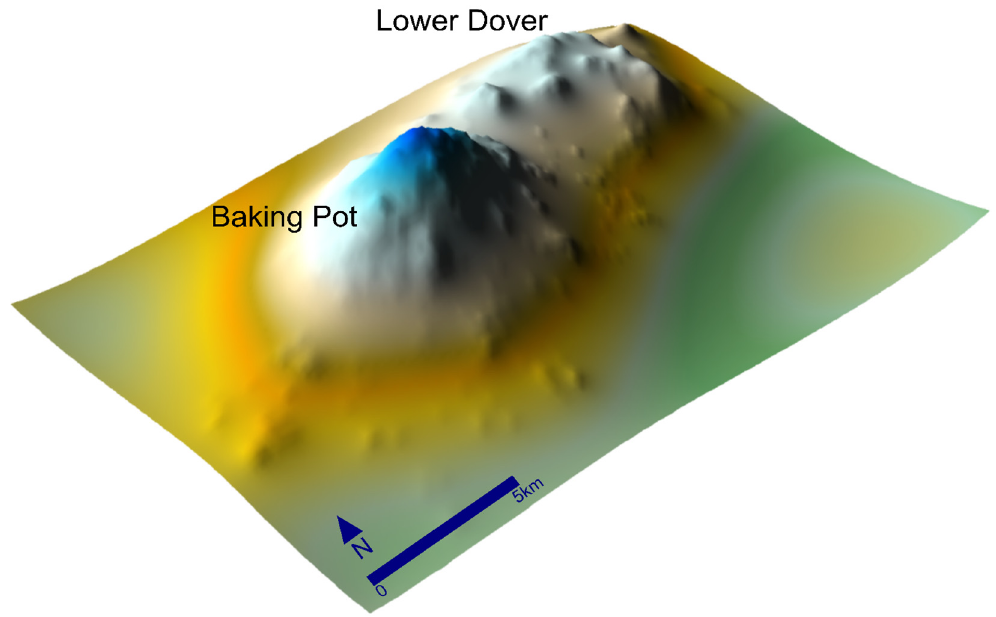
Figure 5. Topographic surface showing demographic centralization at Baking Pot (lower left) and Lower Dover (upper right).